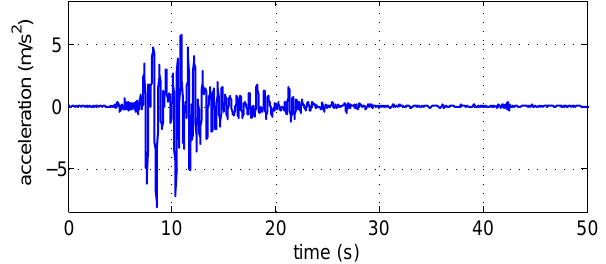
Figure 13: Full-scale North–South 1995 Kobe seismic record with an absolute acceleration peak of 8.18 m/s